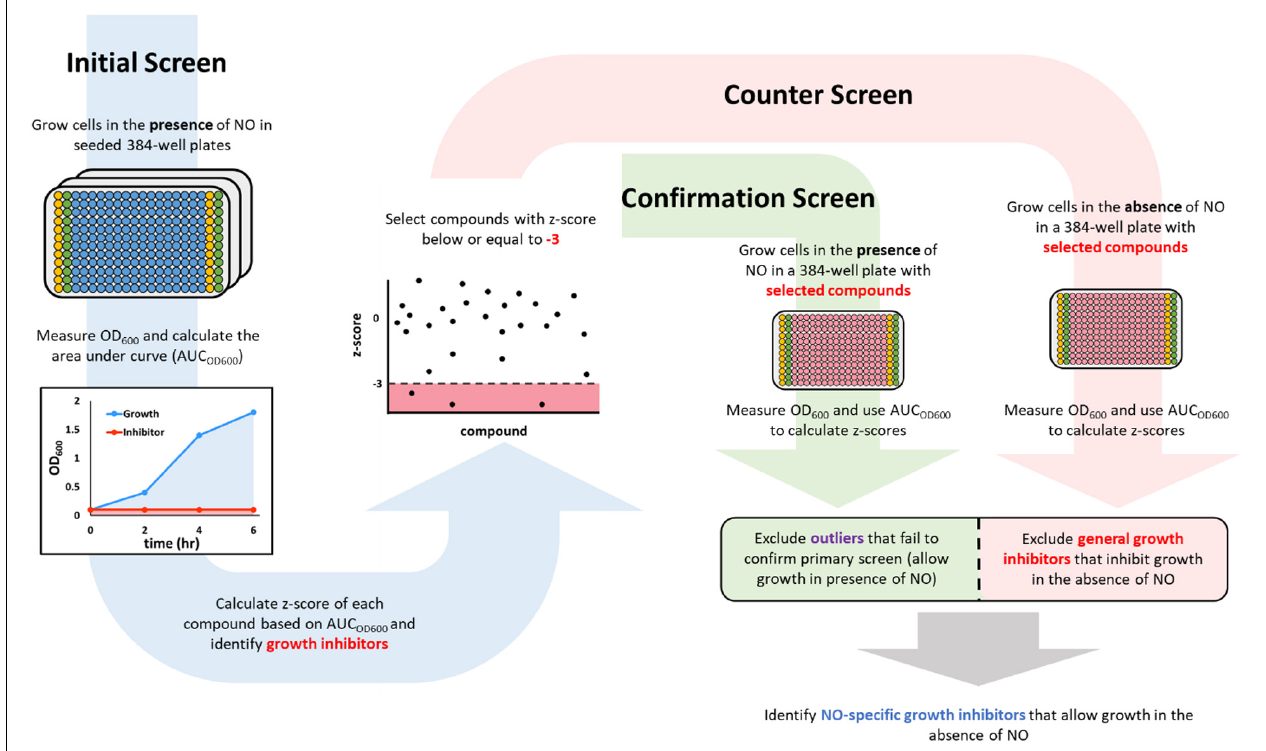
FIGURE 1 | A schematic description of the screening workflow. In the initial screen (blue arrow on the left), 384-well plates were seeded with compounds (blue wells) from a chemical library in the Princeton University Small Molecule Screening Center. The columns on the edges were used to run positive (yellow wells that contained 100 µ M KCN) and negative (green wells that contained DMSO). After the addition of cells and DPTA, growth in each well was monitored by measuring OD 600 , which was used to calculate an area under the curve (AUC OD600 ). Compounds that inhibited growth in the presence of NO would have a low AUC OD600 (red shaded area), whereas those that allowed growth would yield a high AUC OD600 (blue shaded area). Inhibitors from the initial screen (those with a z -score < –3) were then passed on to a confirmation screen (green arrow in the middle), in which growth inhibition in the presence of NO was verified, and a counter screen (red arrow on the right), in which growth in the absence of NO was measured. Compounds that failed the confirmation test (green square) or were growth inhibitory in the absence of NO (red square) were discarded. The remaining compounds were identified as NO-dependent growth inhibitors because they allowed growth in the absence of NO, but inhibited growth in the presence of NO at a concentration that could not inhibit growth on its